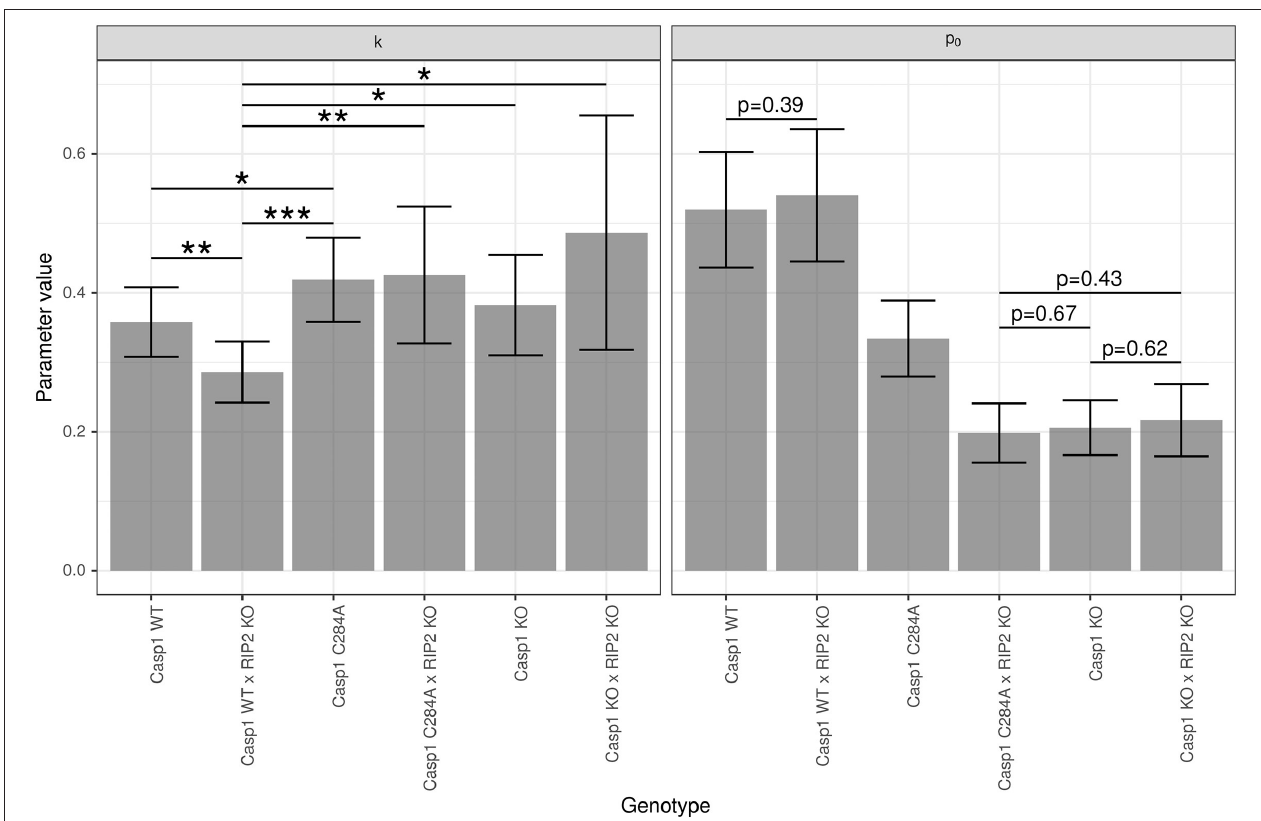
1 and p 0 (dimension-less number) was performed using model h (cid:2) (cid:3)